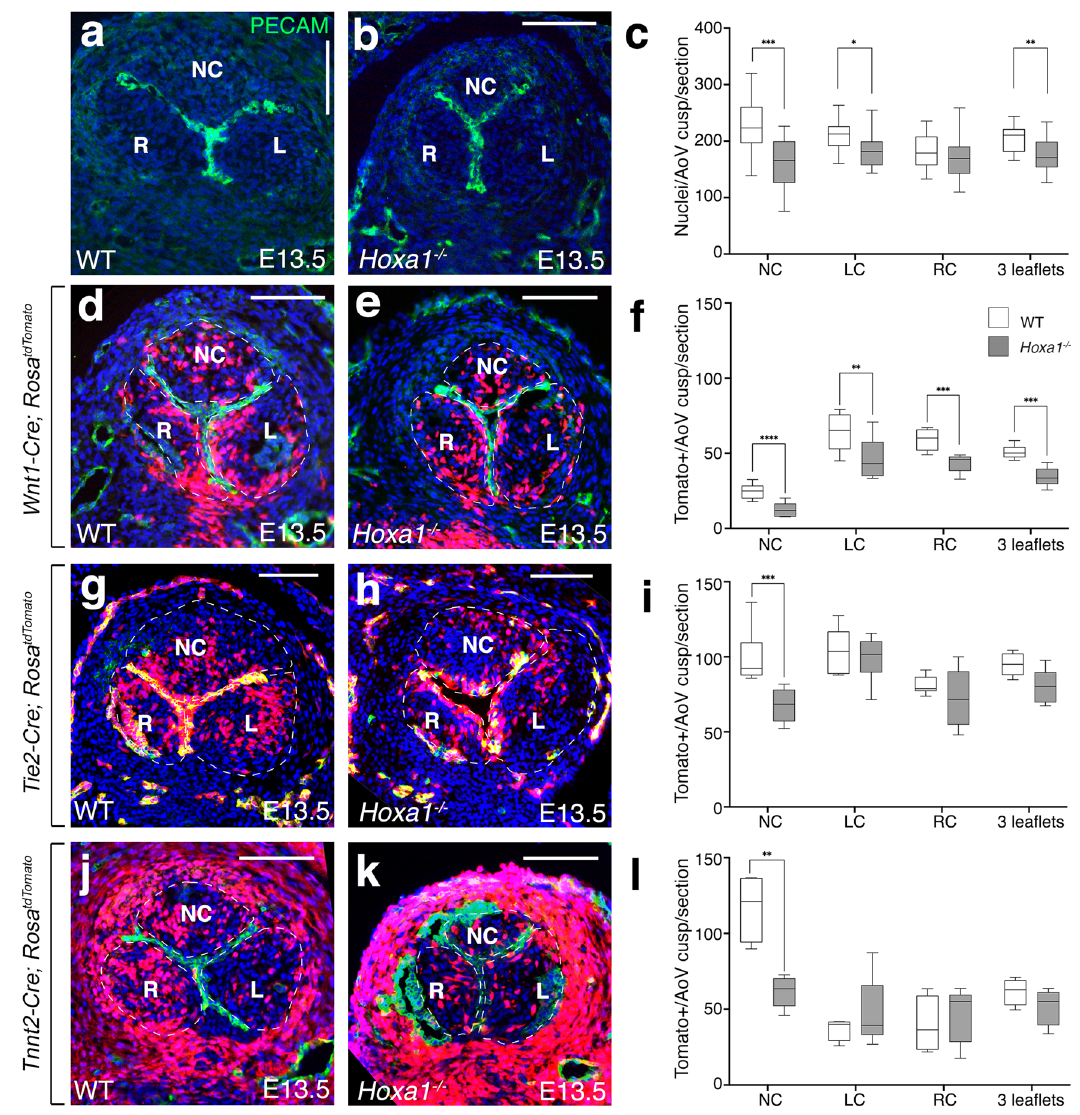
Fig. 5 | Analysis ofcell lineage contribution in Hoxa1 -nullmice.a , b Transversal sections of E13.5 hearts immunostained with an endothelial marker (anti-Pecam antibody,green)andDAPIstainingfornuclei(blue).Notethesmallernon-coronary (NC) lea fl et in Hoxa1 − / − ( b ) compared with WT ( a ) embryos. c Total nuclei were counted in the three forming aortic valve lea fl ets from Hoxa1 − / − ( n =20) and WT ( n =18) embryos at E13.5 spanning a 180 μ m depth (*** p =0.0006; ** p =0.0009; * p =0.01). d – l Fate-mapping of the neural crest-, endothelial- and second heart fi eld-lineagesinthe aorticvalvesof WT( d , g , j ),and Hoxa1 -null( e , h , k )embryosat E13.5. Tomato-reporter is visualized in red and nuclei (DAPI) appear in blue. d , e Immuno fl uorescencestainingusing Wnt1-Cre ; Rosa tdTomato/+ reportermiceshows a decrease in the number of neural crest derivatives in absence of Hoxa1 . f Quanti fi cation of neural crest-derived cells demonstrates signi fi cant decrease in Hoxa1 − / − ( n =5) compared to WT ( n =6) littermate embryos (**** p =0.008;*** p =0.004;** p =0.03).Areaofinterestisindicatedbyadottedline. g , h Immuno fl uorescence staining using Tie2-Cre ; Rosa tdTomato/+ reporter mice